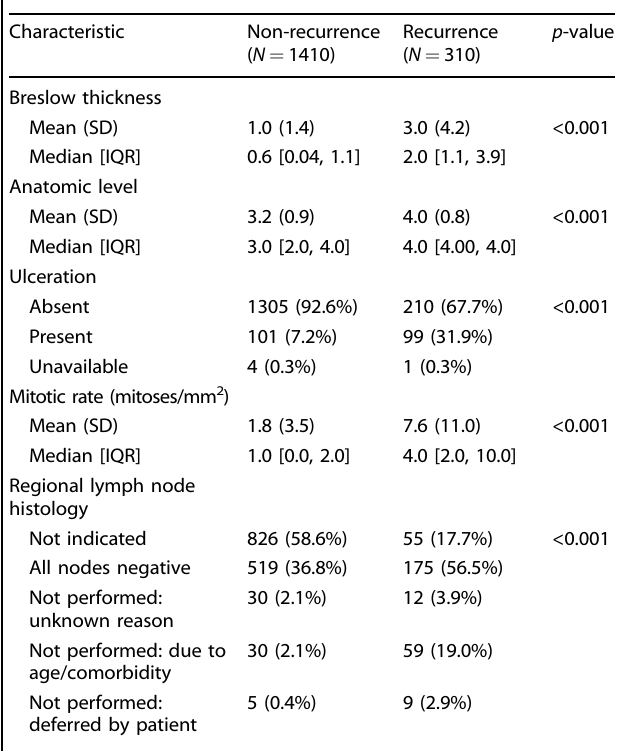
Table 4. In the MGB cohort, the median follow-up was 11.4 (IQR: